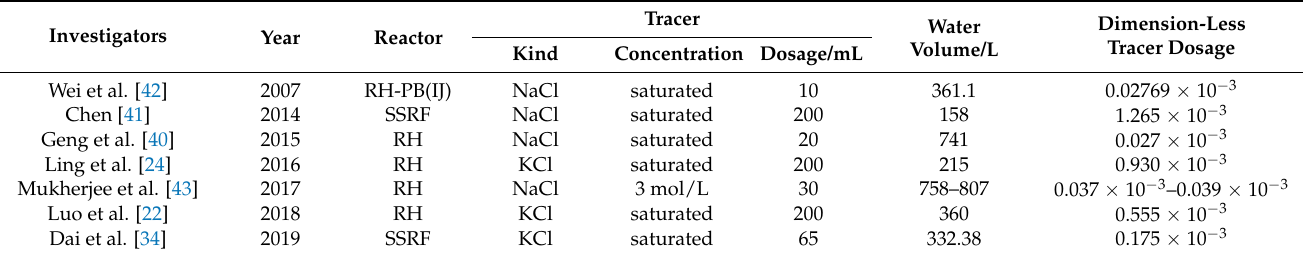
Table 1. Summary of tracer injection in the water model of RH and